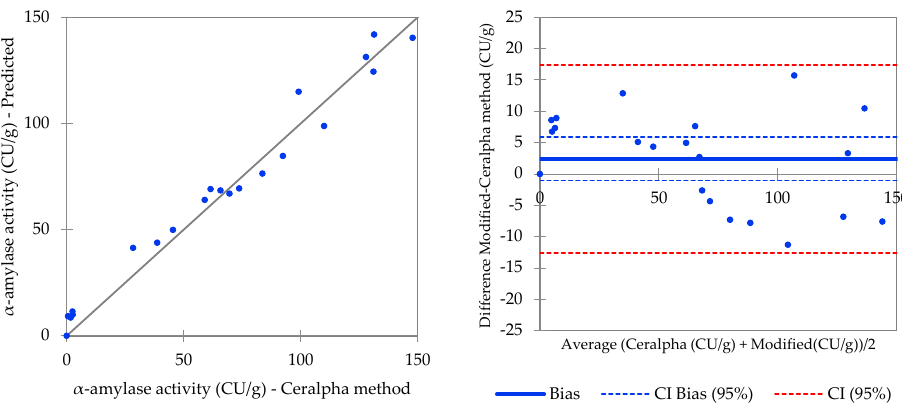
Figure 3. The Bland-Altman analysis of the agreement between the Ceralpha method and the proposed modified FN method using 0.1 g of malt flour (Linear estimation of